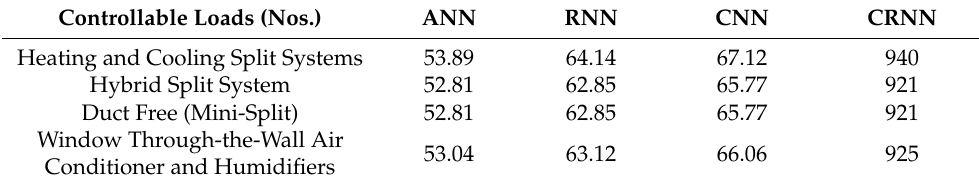
Table 1. Transmission rate (MBPS) in a single smart building. Controllable loads (Nos.)